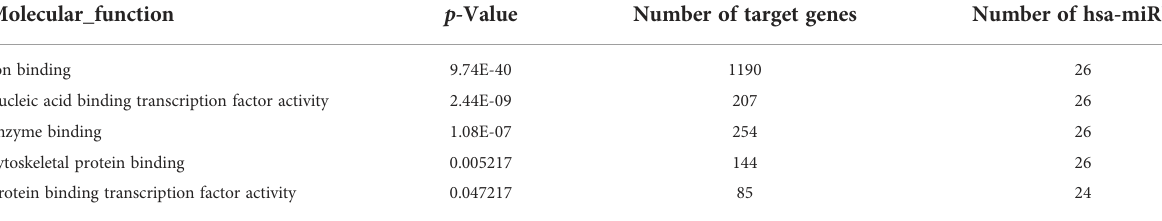
TABLE 2 Putative molecular functions of target host miRNAs of HCMV